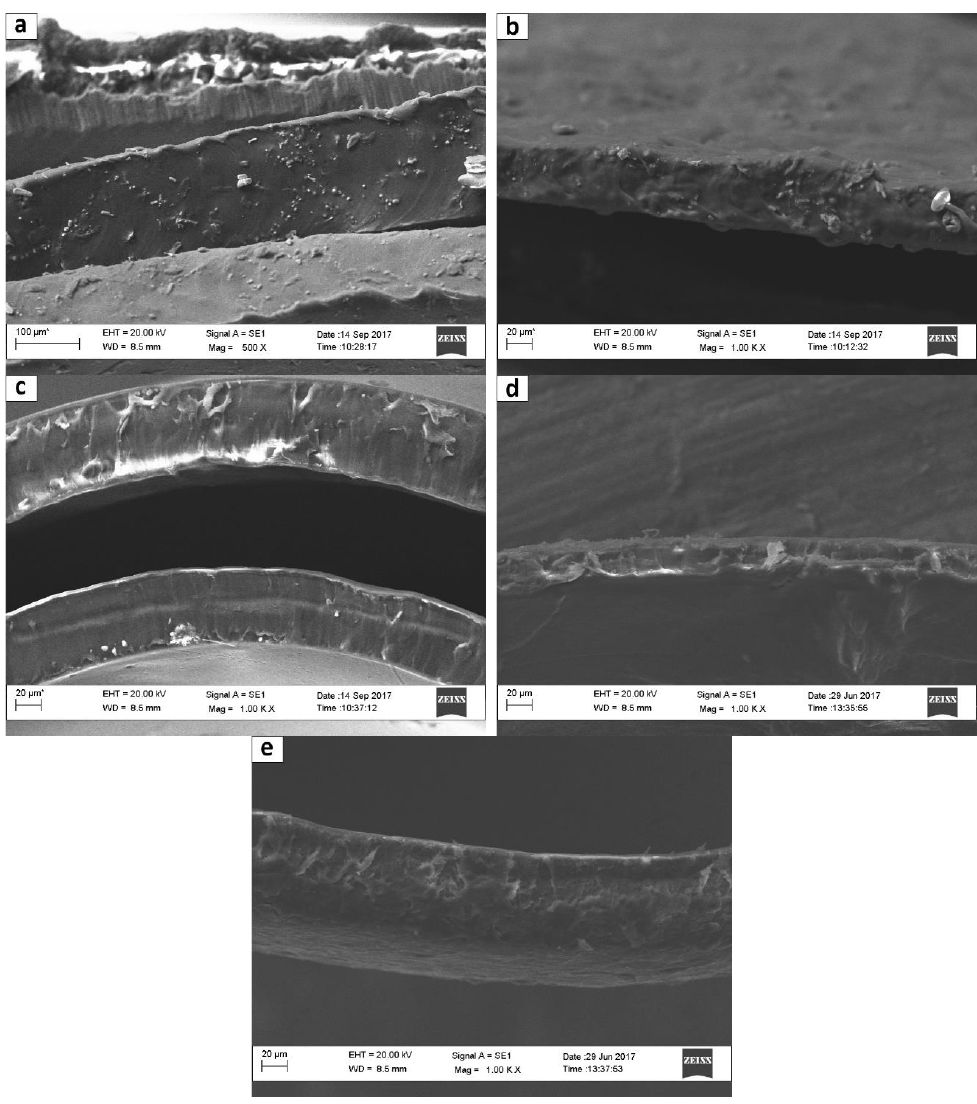
Figure 8. SEM images of the fracture surfaces of: ( a ) PVAm-LG; ( b ) PVAm-LG + 3% GO; ( c ) PVAm-HG; ( d ) PVAm-HG + 3% GO; and ( e ) PVAm-HG + 3% G.